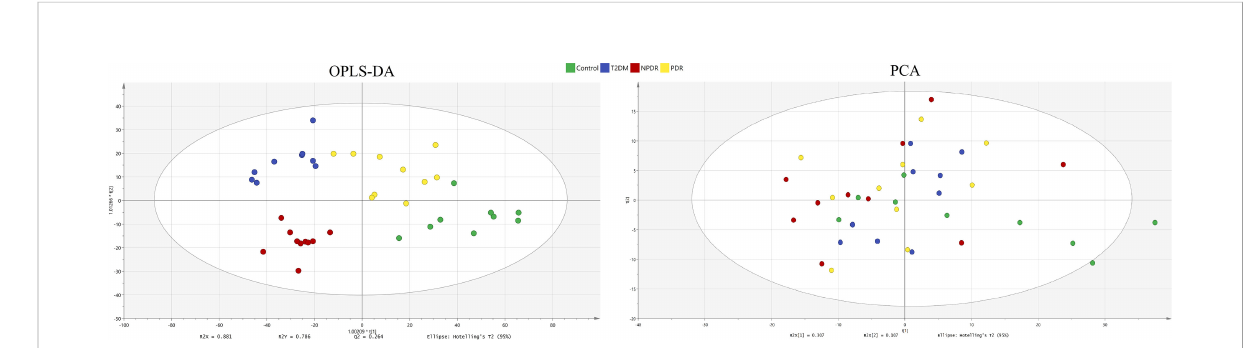
FIGURE 2 OPLS-DA model and PCA model. The four groups were well separated in the OPLS-DA score plot (R2X = 0.881, R2Y = 0.786 and Q2 = 0.264.) The PCA model for samples collected from 4 isolates of sample data. Green dot: control. Blue dot: T2DM sample. Red dot: NPDR sample. Yellow dot: PDR sample. OPLS-DA, orthogonal partial least squares- discriminant analysis; PCA, principal component analysis; T2DM, type 2 diabetes mellitus; NPDR, non-proliferative diabetic retinopathy; PDR, proliferative diabetic